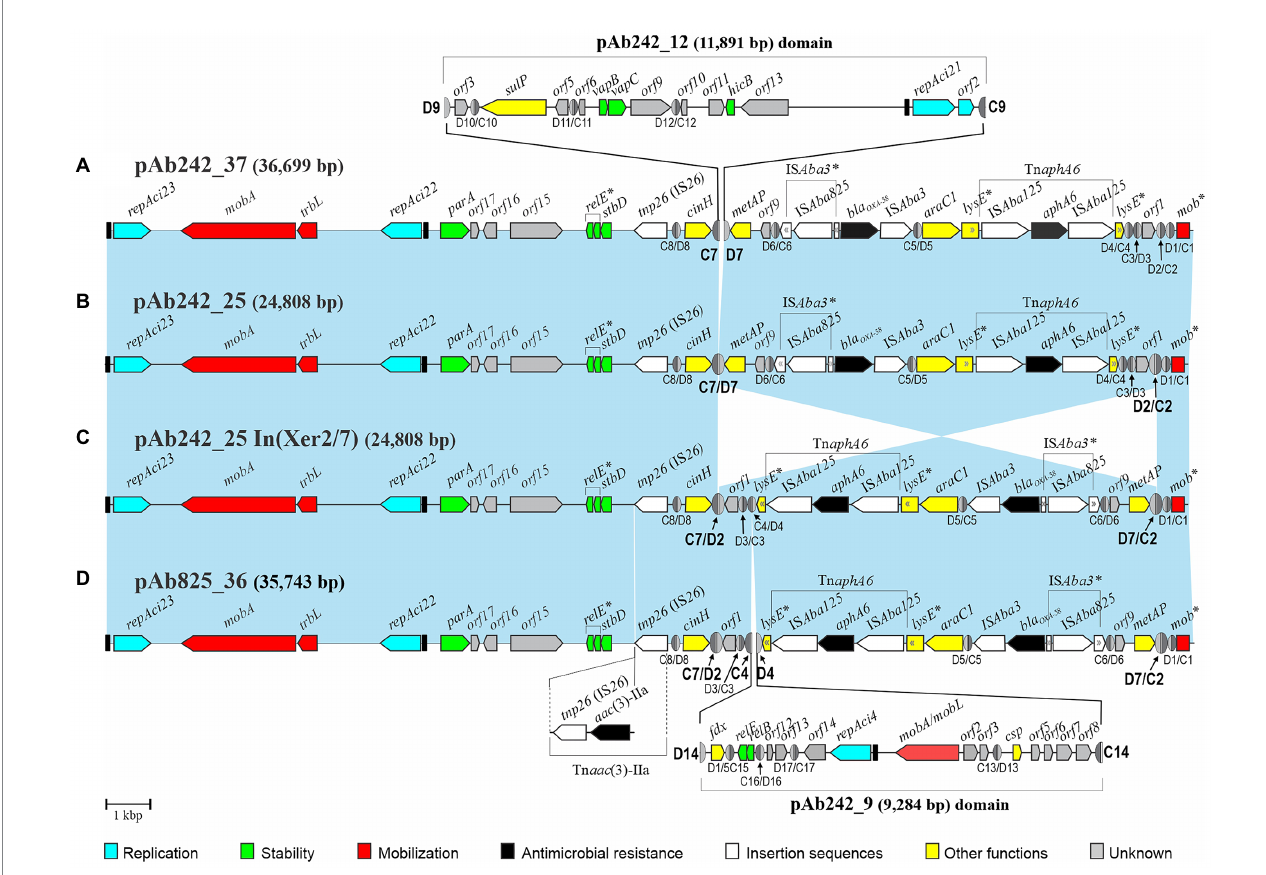
FIGURE 1 Comparisons of the genetic structures of four plasmid structural variants carrying identical bla OXA-58 - and Tn aphA6 -containing resistance modules bordered by multiple pXerC/D sites identified among related Acinetobacter baumannii clinical strains studied in this work. Linear representations of four Rep_3-based multi-replicon resistance plasmids characterized in the Ab242 and Ab825 strains. For comparison purposes all plasmids were drawn starting from the iteron sequences region located immediately upstream of the repAci23 replication initiation protein gene (black rectangle at the left), with the orientations and extents of the different genes and open reading frames also shown. The genes containing premature termination codons, insertions, and pseudogenes are labeled with asterisks. The genes encoding the different replication initiation proteins belonging to the Rep_3 superfamily are denoted as repAci followed by their assigned denominations, with their preceding iteron sequences indicated as black rectangles. The carbapenem- and aminoglycoside-resistance module (RM) encompassing the bla OXA-58 - and aphA6 resistant genes and accompanying elements is found in all plasmids associated to multiple pXerC/D sites located in different orientations. The light-blue shaded background interconnecting the structures of the different plasmids denote homologous regions displaying nucleotide sequence identity ≥ 99%, the cross sectors indicate the inverted regions found between plasmids. Antimicrobial resistance genes are labeled in black and IS elements in white, with their corresponding denominations indicated above each plasmid structure. The extension of the IS Aba125 -based composite transposon Tn aphA6 inserted within the lysE gene is also indicated. The different pXerC/D-like sites inferred in these plasmids are shown as ovals (not drawn to scale), with the XerC (C) and XerD (D) recognition sequences depicted as dark and light gray semi-ovals, respectively. Their designations (see Cameranesi et al., 2018 for numbering and sequence details) and corresponding polarities are indicated below the structures. The pXerC/D sites identified as involved in SSR have been enlarged, and their designations highlighted in bold letters. (A) pAb242_37 structure. This tri-replicon resulted from an intermolecular fusion mediated by the pXerC/D pair C7/D7 and C9/D9 sites located in pAb242_25 and pAb242_12, respectively (Cameranesi et al., 2018). The structure of pAb242_12 and its insertion site into pAb242_25 are indicated above the structure, and resulted in the generation of a directly-oriented pair of (hybrid) sites formed by C7/D9 and C9/D7. (B) pAb242_25. This bi-replicon was assembled from WGS data analysis obtained from the Ab242 strain. (C) pAb242_25 In(Xer2/7). Plasmid structural variant of pAb242_25 described in this work, in which the region located between the oppositely-oriented sites C7/D7 and D2/C2 is inverted. As the result, a novel pair of oppositely-oriented (hybrid) sites, C7/D2 and D7/C2, was generated. (D) pAb825_36. Plasmid assembled from WGS data analysis of the Ab825 strain followed by gap closure using PCR with specifically-designated primers (see Supplementary Figure S3). Sequence analysis indicated that this tri-replicon was formed by the fusion of a plasmid much similar in structure to pAb242_25 In(Xer2/7) and another plasmid identical to pAb242_9, mediated by the pair of pXerC/D sites C4/D4 and C14/D14 located in pAb242_25 In(Xer2/7) and pAb242_9, respectively. This fusion resulted in the generation of a directly-oriented pair of (hybrid) sites, C4/D14 and C14/D4. A complete IS 26 -based composite transposon, Tn aac(3) -IIa, was also found in pAb825_36 and its location is also indicated below the plasmid structure. GenBank accession numbers: pAb242_25, KY984047; pAb242_12, KY984046; pAb242_9, KY984045, pAb825_36,